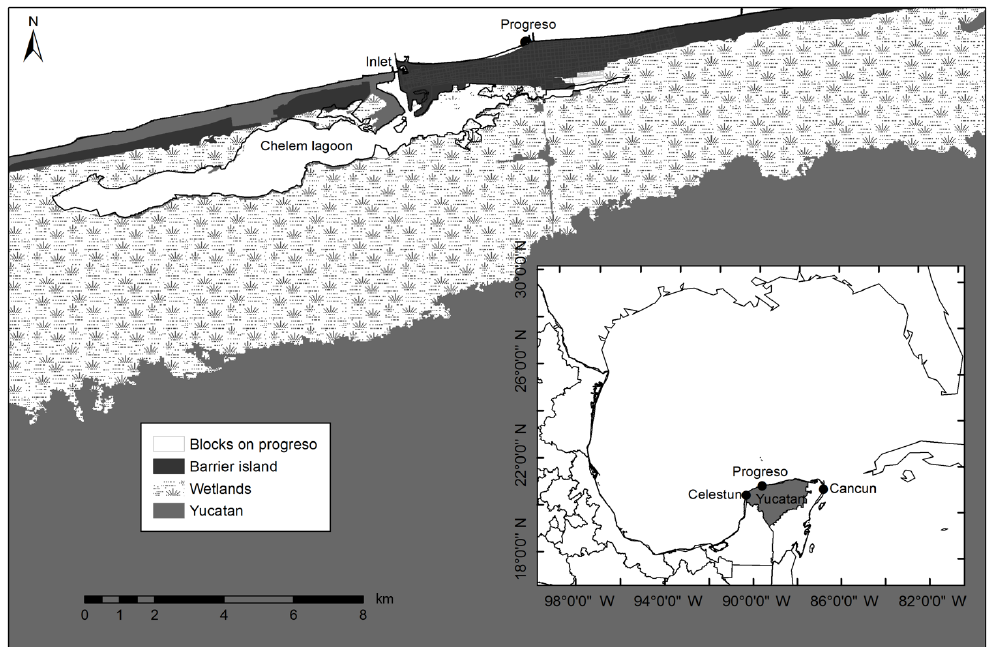
Figure 1. Location map indicating the study zone and the town of